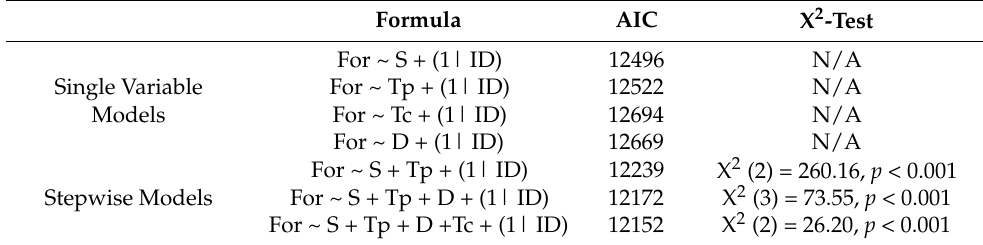
Table A2. Stepwise model selection for Foynes. Details see Table A1.